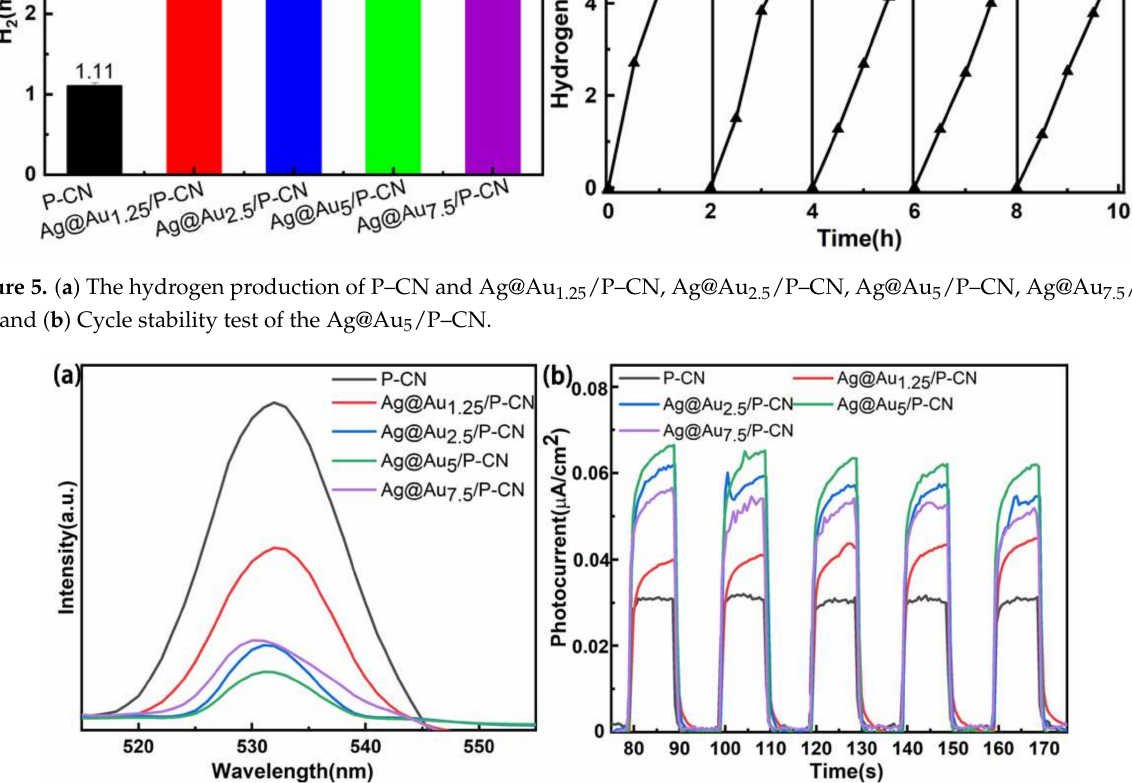
Figure 6. ( a ) PL spectrum of P-CN and Ag@Au 1.25 /P–CN, Ag@Au 2.5 /P–CN, Ag@Au 5 /P–CN, and Ag@Au 7.5 /P–CN. ( b ) The photocurrent of the system with P-CN and Ag@Au 1.25 /P–CN, Ag@Au 2.5 /P–CN, Ag@Au 5 /P–CN, and Ag@Au 7.5